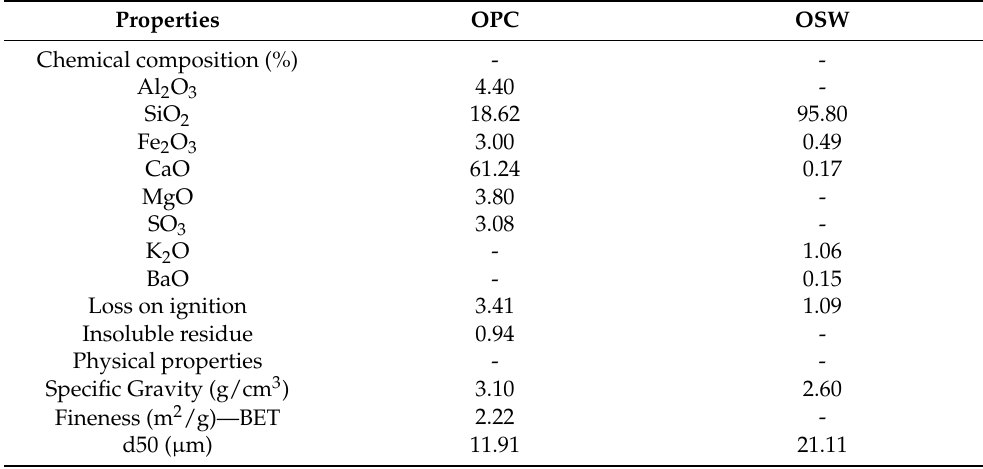
Table 2. Chemical composition and physical properties of the powder